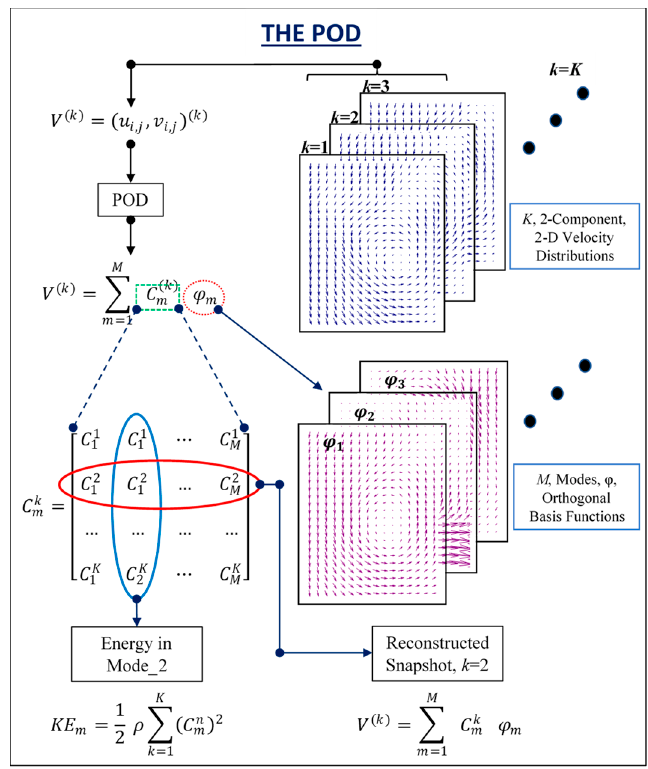
Figure 4. Schematic showing the main principle of POD.